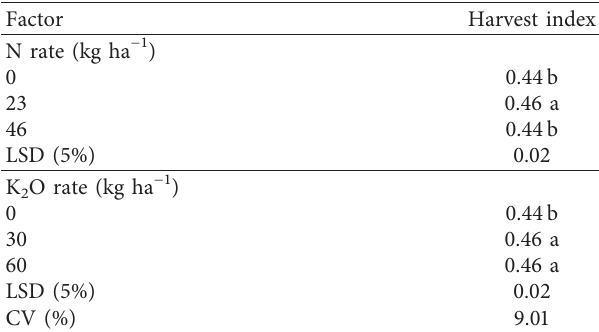
Table 9: Effect of N and P fertilizers on the harvest index of faba